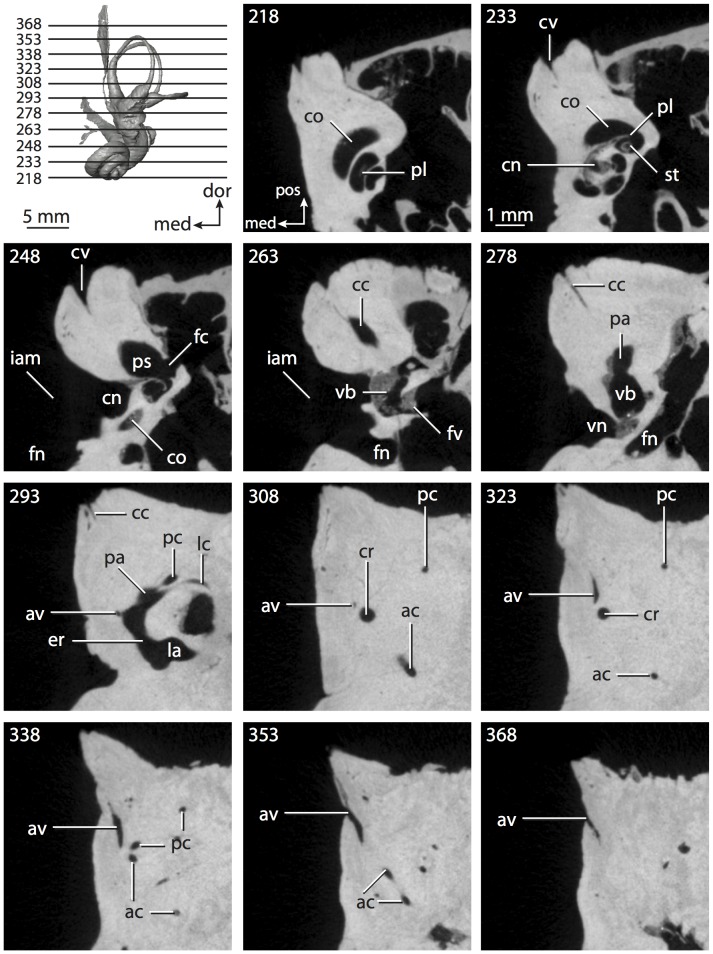
CT slices through ear region ofEquus caballus.
Abbreviations listed at the end of the Materials and Methods section.